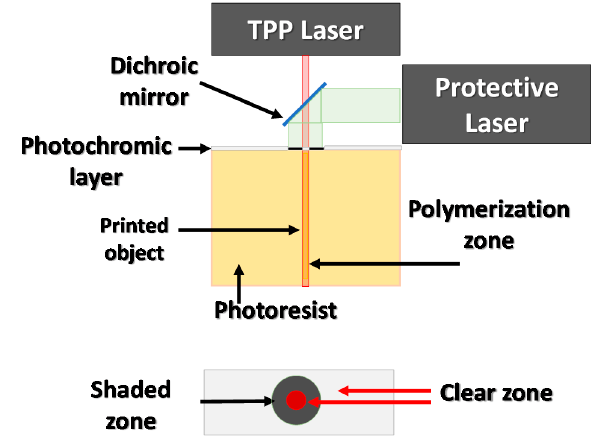
Figure 16. Restricting the curing area of a TPP laser by the application of a photochromic layer on top of the photoresist.